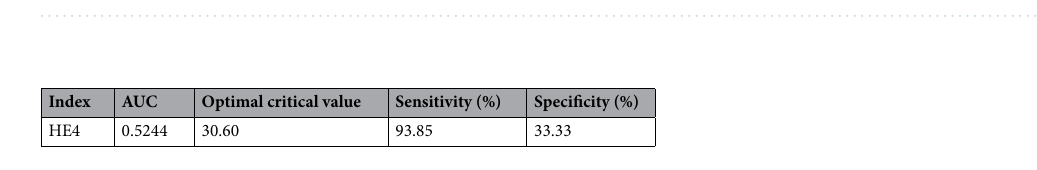
Table 6. Comparisons of the positive rates and levels of HE4 between the FIGO stage I group and the FIGO stage II and above group (n/%).